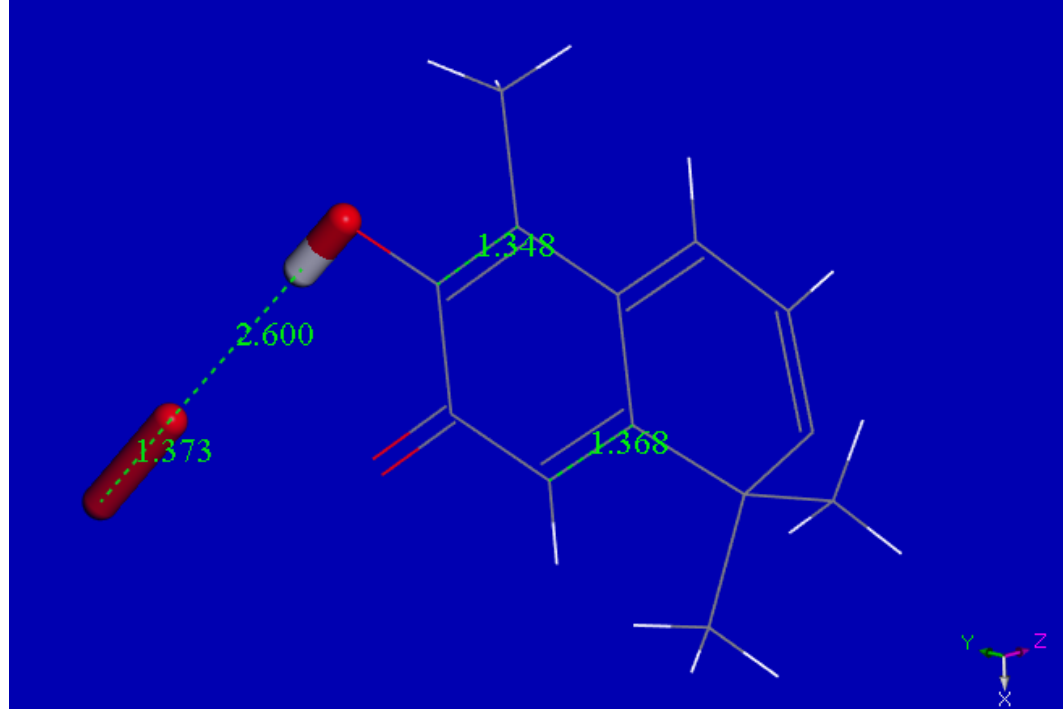
Figure 6. Superoxide σ approached by model celastrol. The celastrol hydroxyl is separated from superoxide by van der Waals distance, 2.60 Å. This is the initial state.